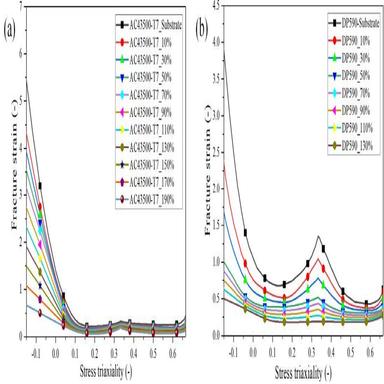
Fracture strain–stress triaxiality curves at different pre-strain levels for (a) AC43500-T7 and (b) DP590.